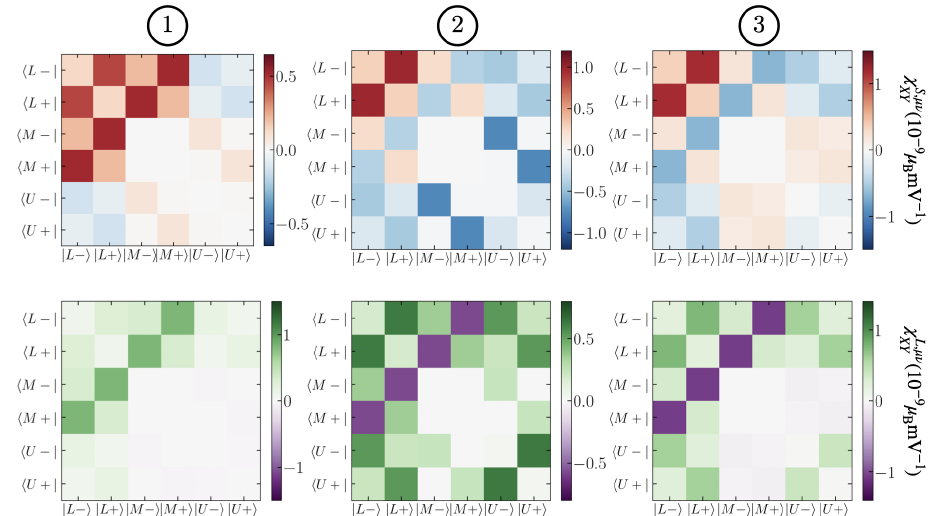
Figure 4. Spin ( upper panel ) and orbital ( lower panel ) Edelstein susceptibility projected over the L , M , and U states. The chemical potential µ is fixed at values 1, 2, and 3, referring to Figure